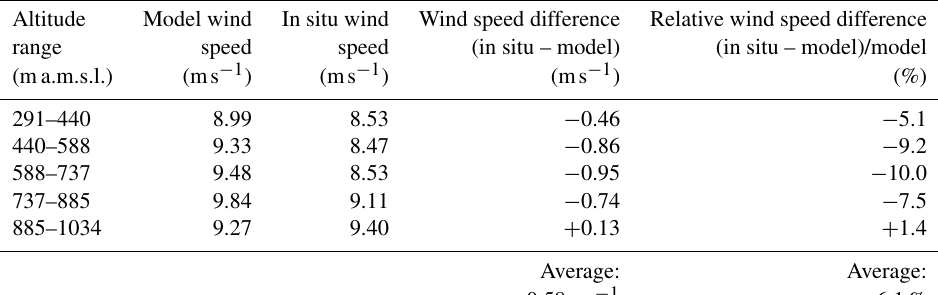
Average: Average: − 0.58ms − 1 −